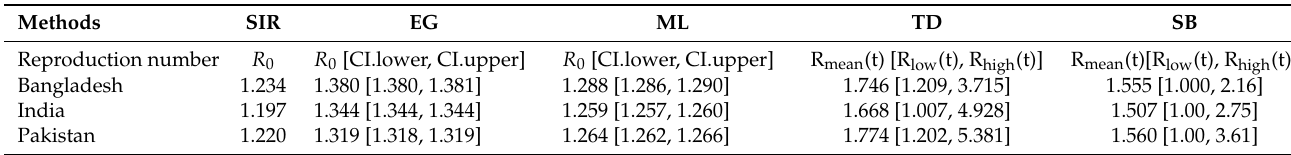
Table 3. R 0 / R ( t ) estimation by different methods.